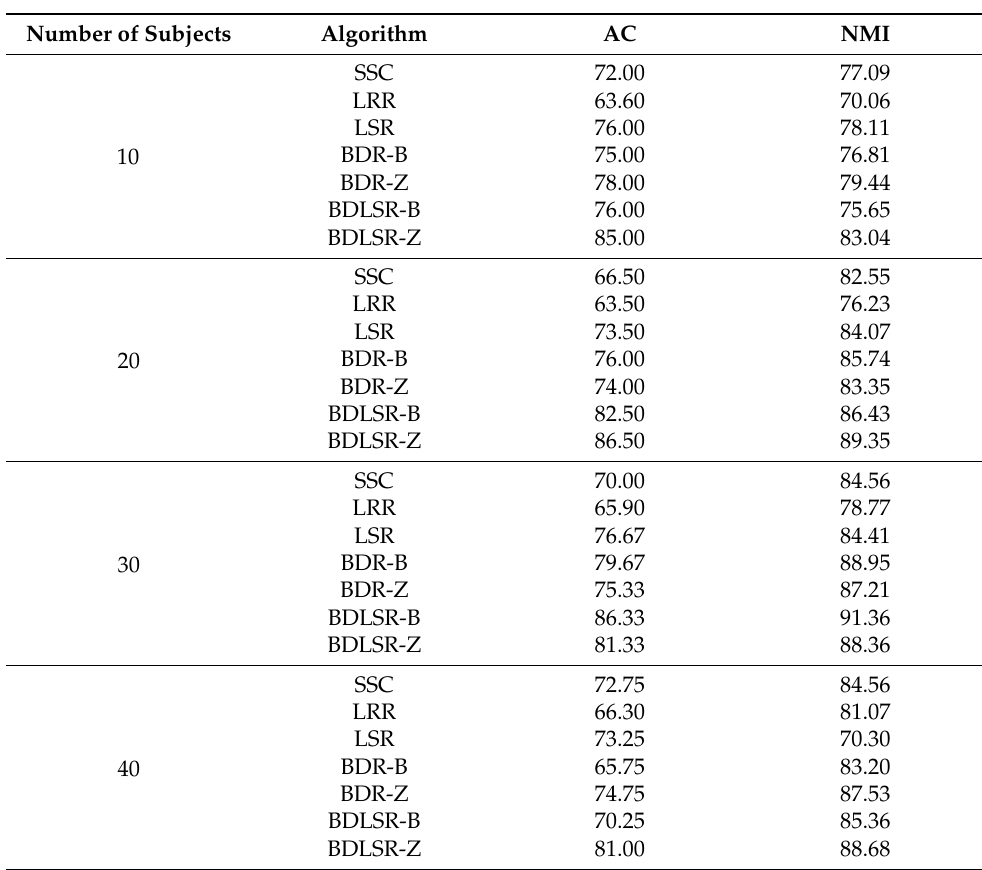
Table 4. The results from the different algorithms when using the ORL dataset